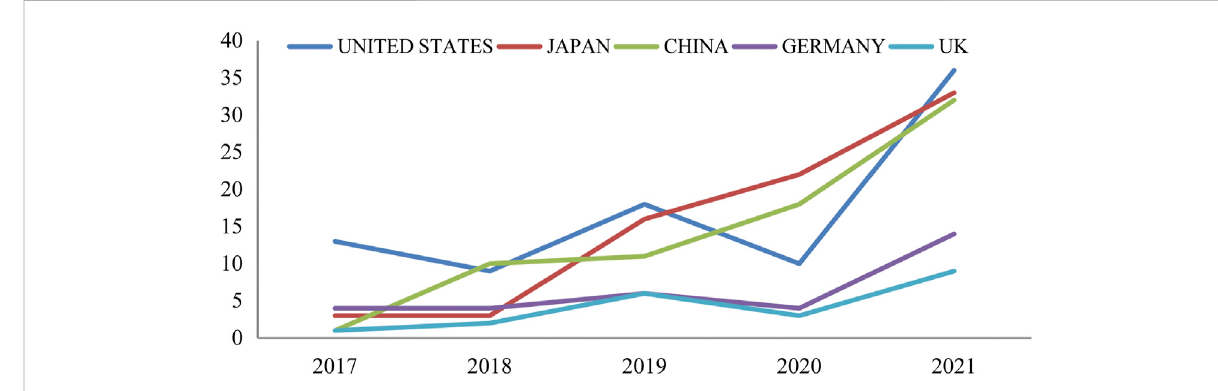
FIGURE 4 The annual HIF-PHI research output of the most 5 high-productive countries.